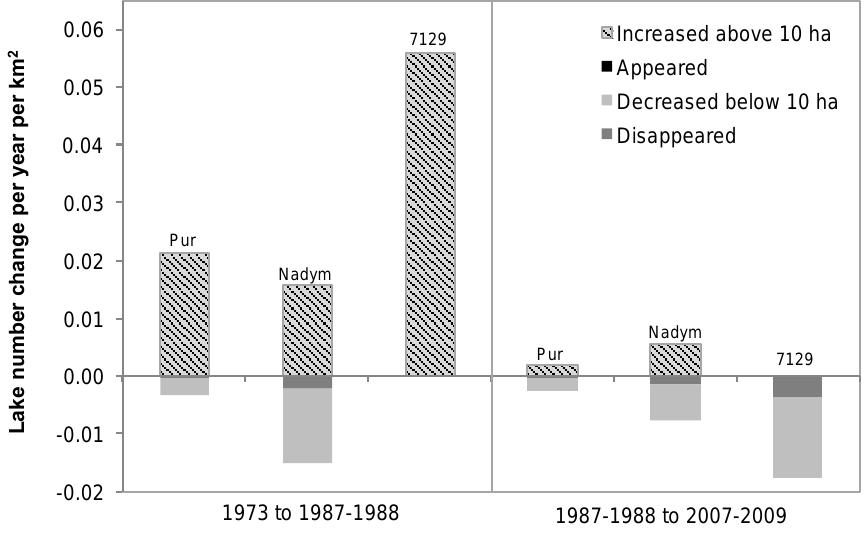
Figure 3. Annual rate of lake number change for lakes with the lower lake area threshold of 10 ha, normalized by total lake area for Pur, Nadym river basins, and 7129